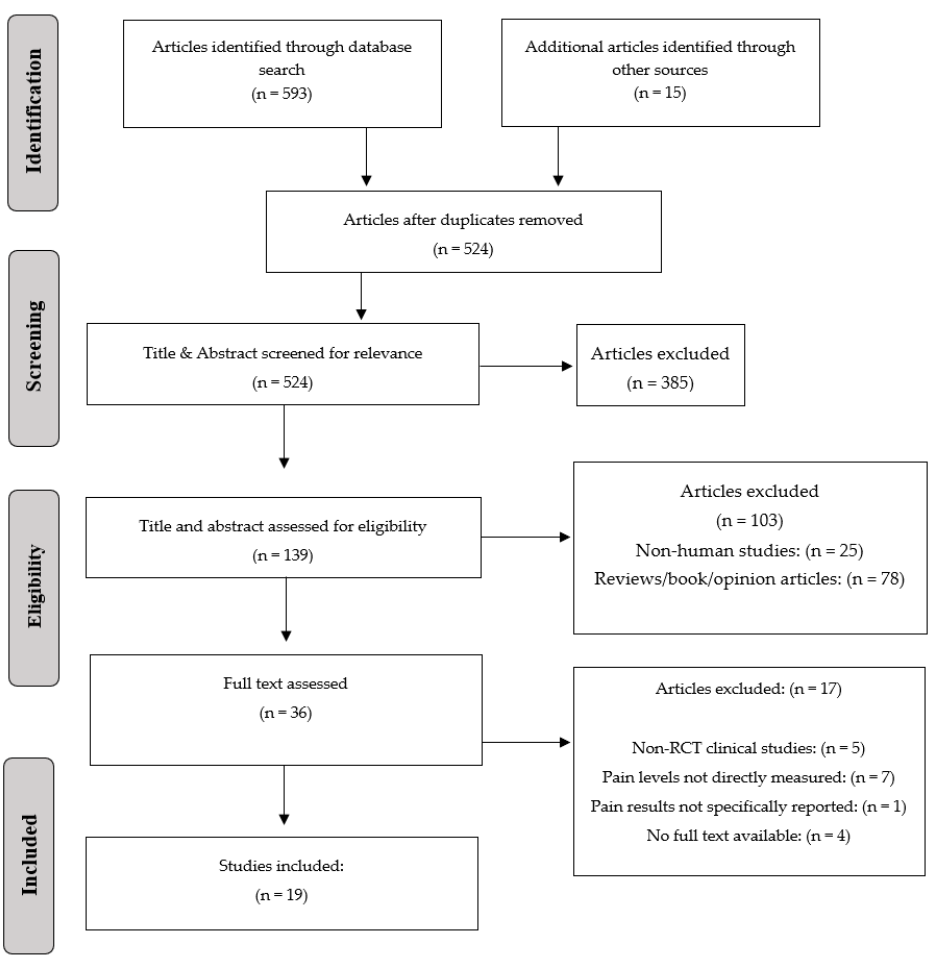
Figure 1. Prisma flow chart.